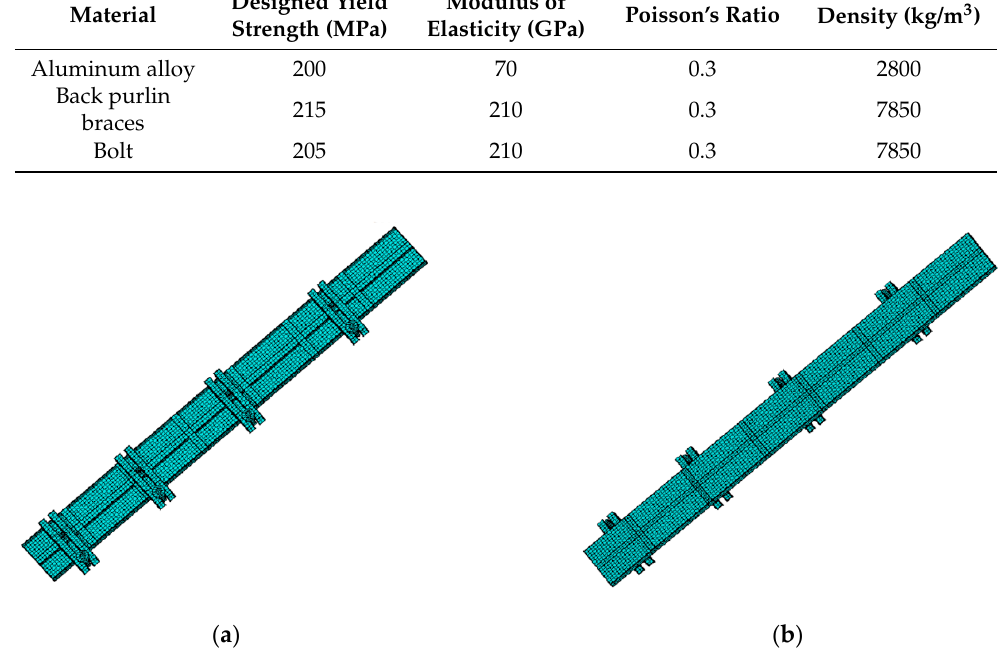
As a semi-structure was built, the symmetry constraint was applied to the plane X =